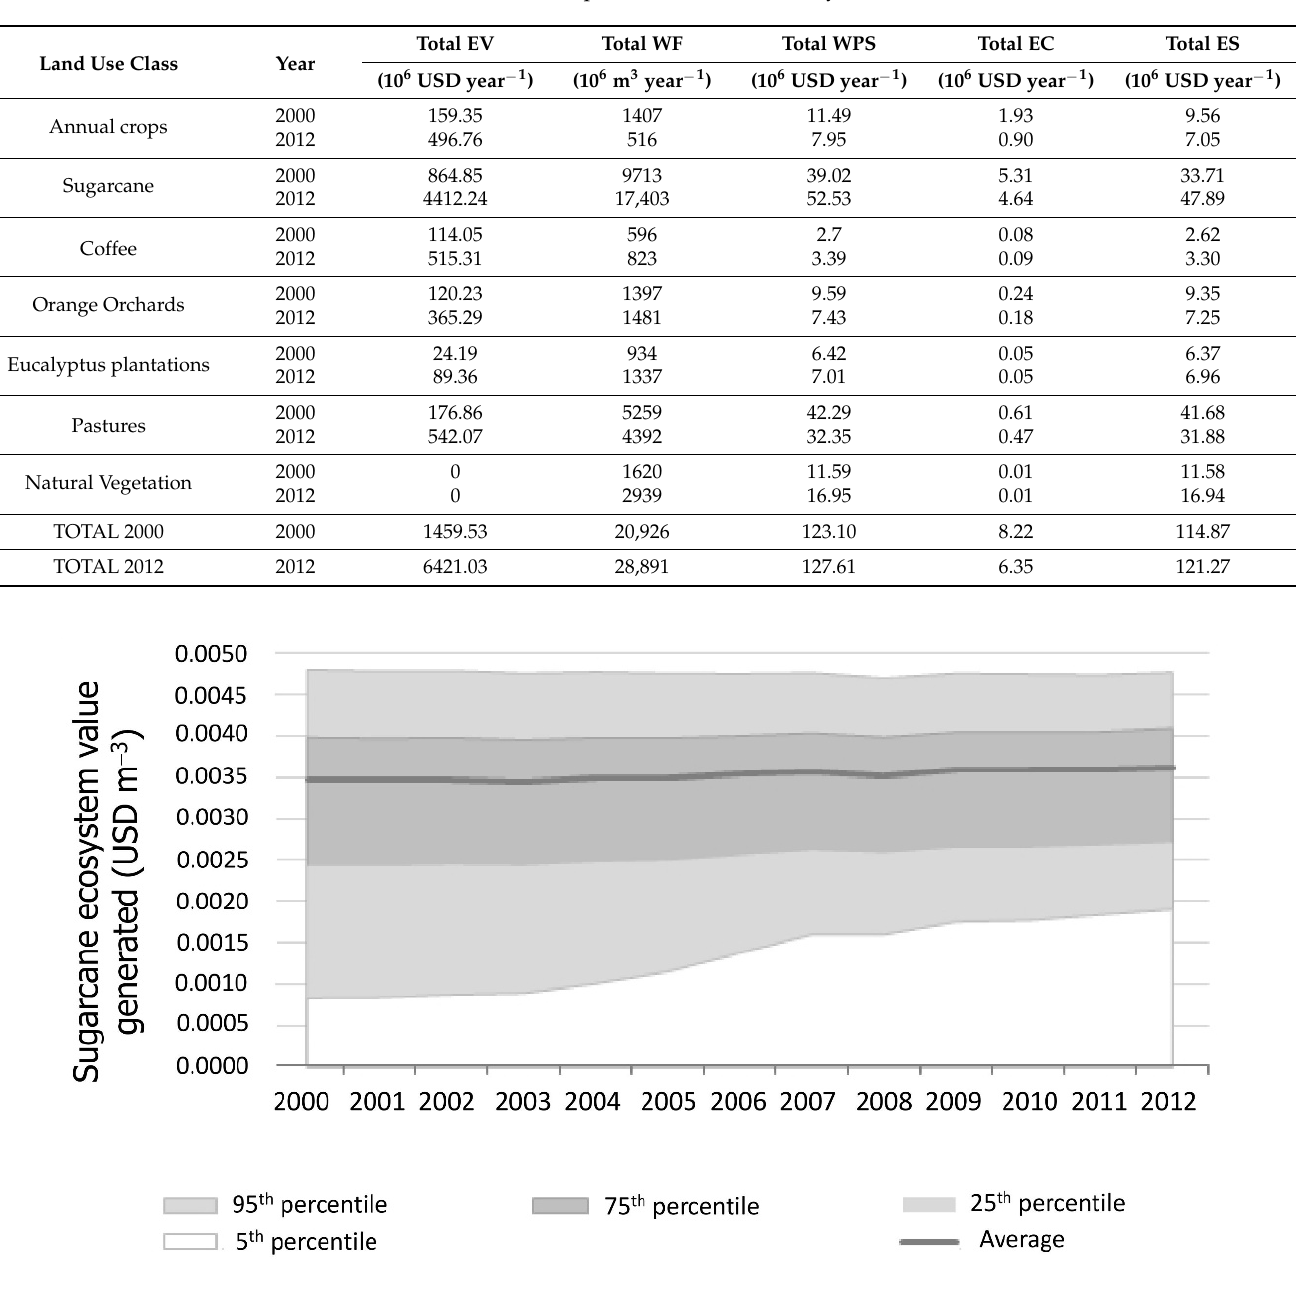
Table 1. Total economic value (EV), WF, value of water provisioning (WPS), cost associated with erosion (EC), and ES value per land use class in the years 2000 and 2012.